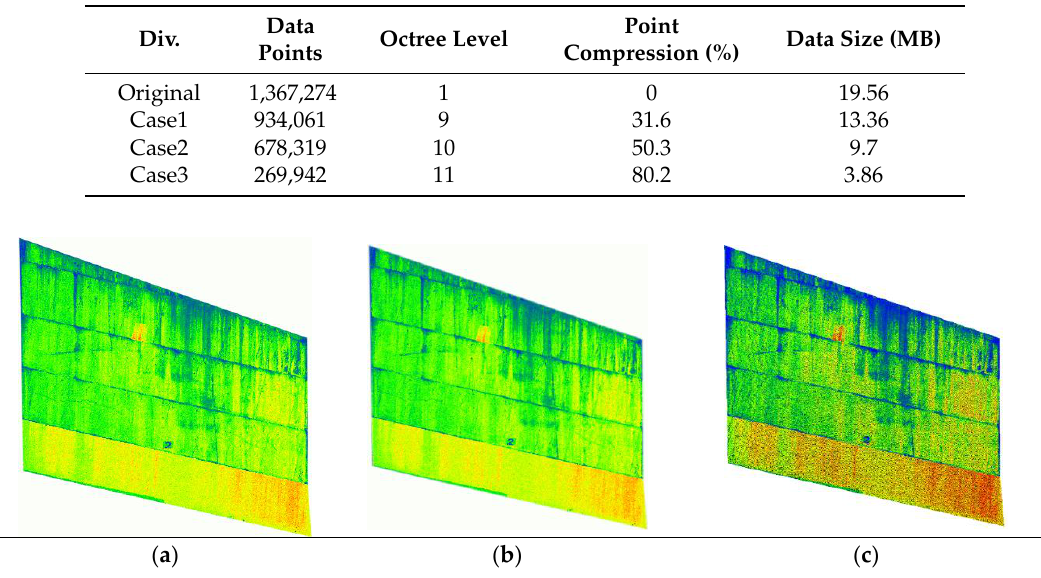
Figure 12. The TLS scan images by point compression rates. ( a ) Case 1; ( b ) Case 2; ( c ) Case 3.